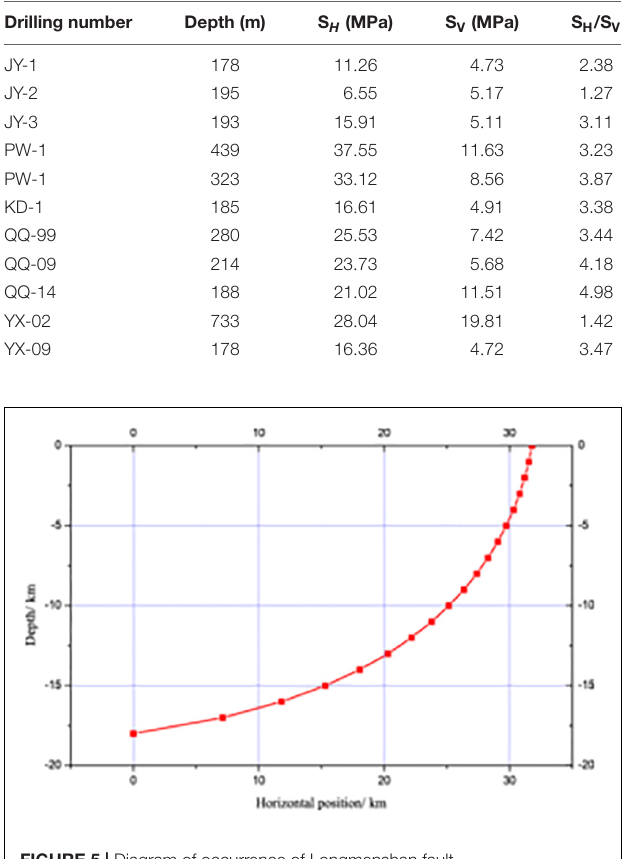
FIGURE 5 | Diagram of occurrence of Longmenshan fault.